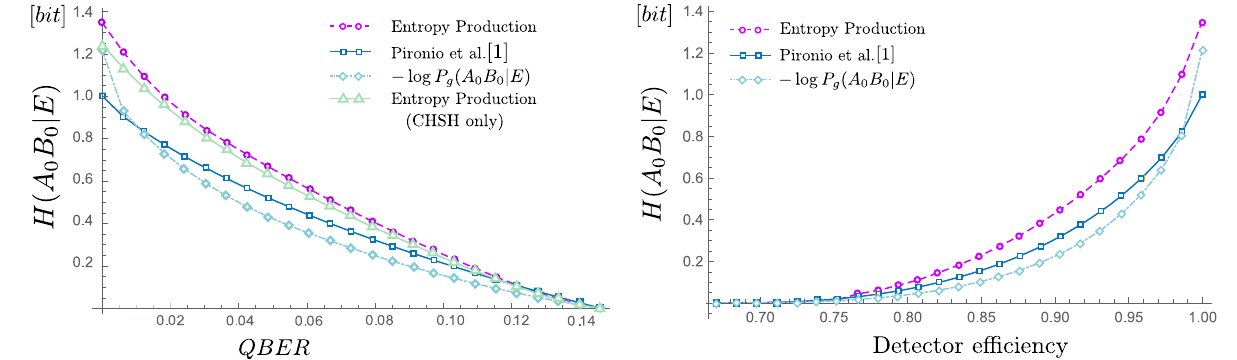
Fig. 4 2-input 2-output DI protocols, H ( A 0 B 0 ∣ E ) (in base 2). Lower bounds on H ( A 0 B 0 ∣ E ) as a function of depolarizing noise (for the scenario studied in 1 ) or detection ef fi ciency (for the scenario studied in 43 ). Our approach outperforms both previous approaches, namely indirect bounds via the one-party entropy H ( A 0 ∣ E ) (using the bound in 1 ) or the guessing probability. We also show a curve obtained when applying our method with only the CHSH value as the constraint, instead of the full output distribution.